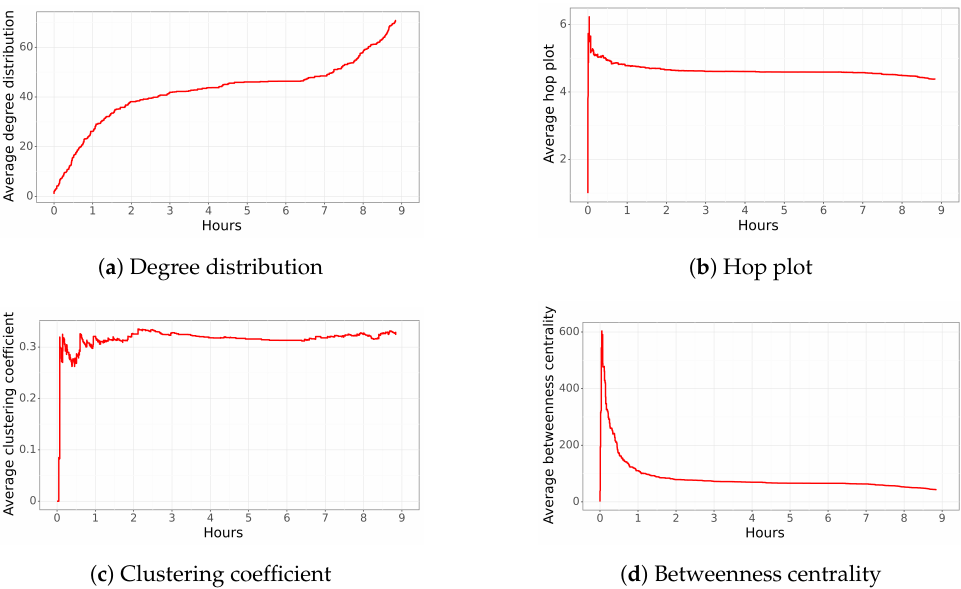
Figure 7. Average network characteristics for the “front line” over